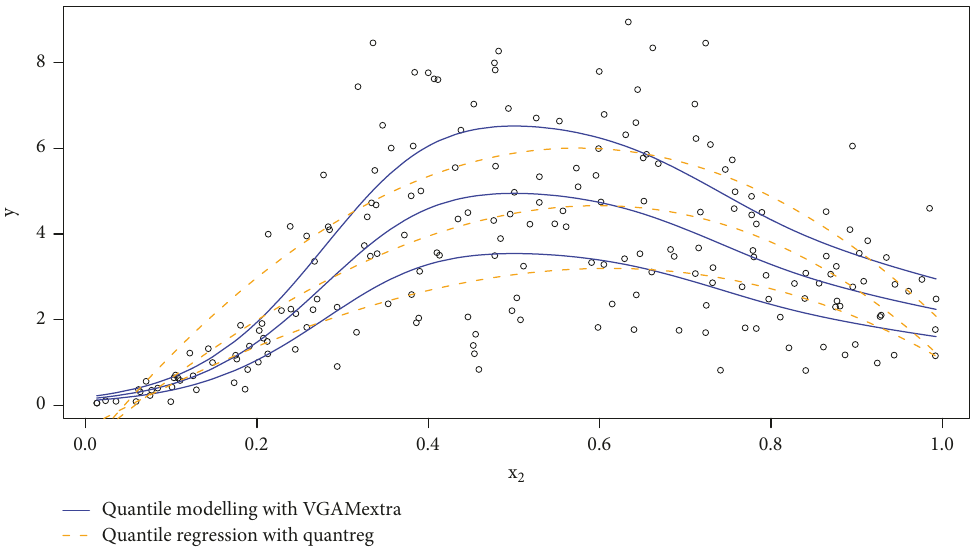
Figure 2: Simulated Maxwell data (21) including ( a ) the fitted quantile functions from fit.Qmodelling ( VGAMextra ) and ( b ) the fitted quantile curves from qrfit50 , etc. from quantreg